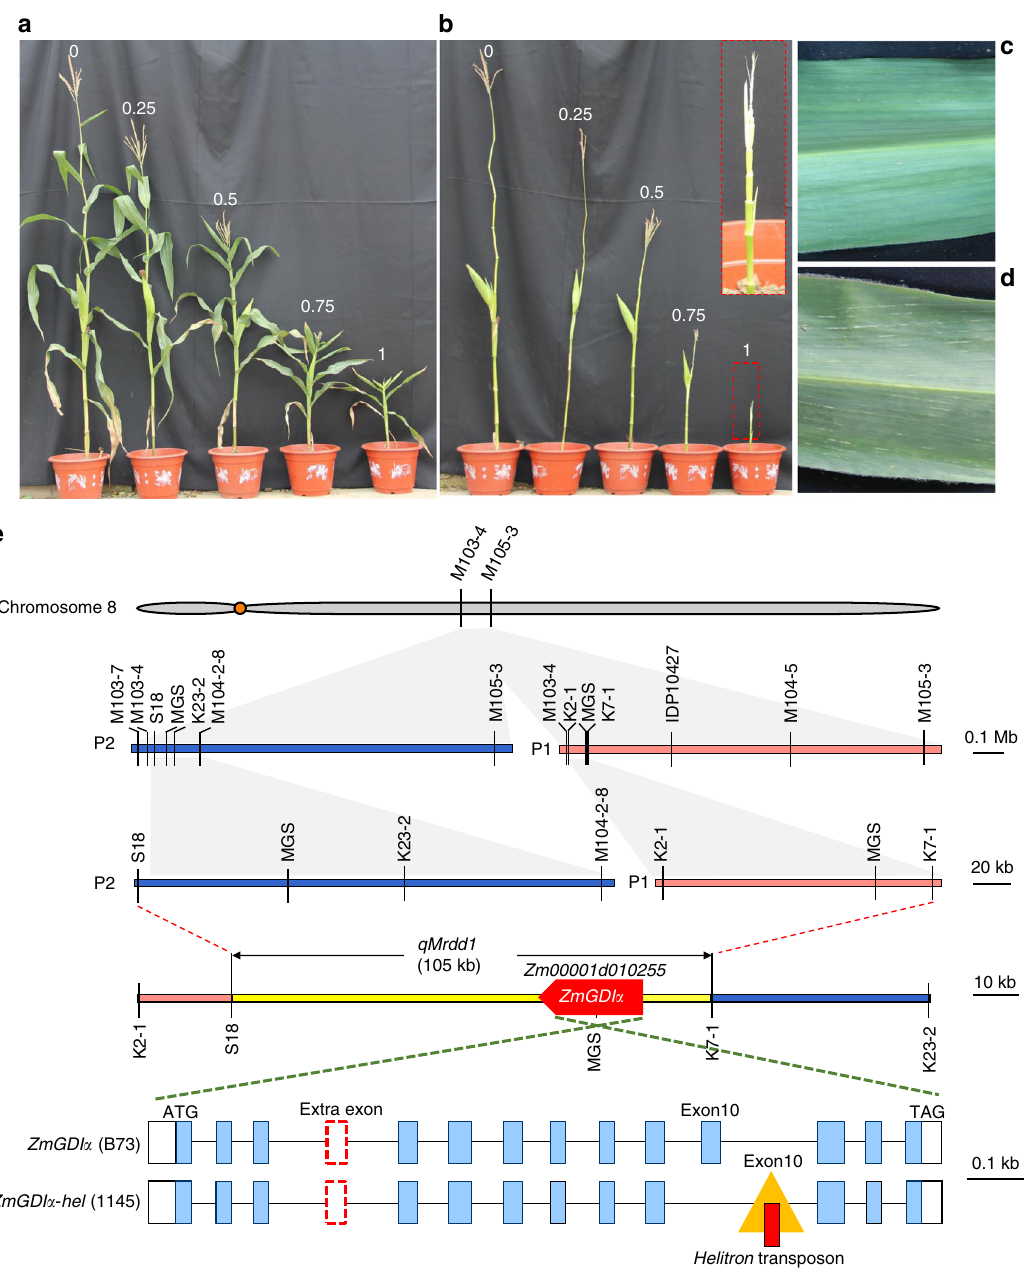
Fig. 1 Fine-mapping of the MRDD resistance QTL qMrdd1 . a , b The RBSDV-infected maize plants are characterized by stunted growth ( a ) and shortened internodes ( b ). The numbers in a / b indicate a fi ve-grade scale, ranging from healthy plant (grade 0) to severely diseased plant (grade 1). c , d The absence ( c healthy plants) or presence ( d severely diseased plants) of waxy enations on the axial surfaces of upper leaves. e Fine-mapping of qMrdd1 . The mappings with the P1 (salmon pink bar) and P2 (navy blue bar) populations, derived from crosses between the inbred lines NT409 (susceptible) and NT411 (resistant) and between HuangC (susceptible) and X178 (resistant), respectively, are depicted on the right and left, respectively. The overlapped S18/K7-1 interval (105 kb; yellow bar) is inferred to encompass the causal genetic factor for qMrdd1 . The candidate gene RabGDI α (code: Zm00001d010255 ) is depicted as a red arrow. The structures of the candidate genes in the susceptible B73 ( ZmGDI α ) and resistant 1145 ( ZmGDI α -hel ) lines are shown below, with blue boxes representing exons, white boxes representing the 3 ′ - and 5 ′ -UTRs, and the red dashed box representing the extra exon of the long transcript. The helitron insertion (golden triangle) in intron 10 results in alternative splicing, which replaces the wild-type exon 10 with a helitron -derived exon 10 (red box within the golden triangle) to create ZmGDI α -hel qMrdd1 acts in a recessive genetic mode in MRDD resistance (Supplementary Fig. 2d).